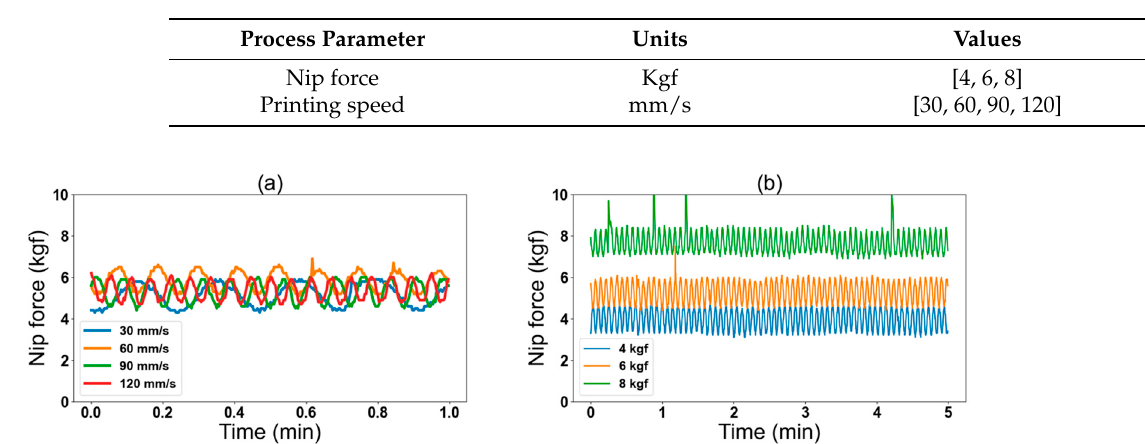
Table 3. The nip-speed experiment parameters.